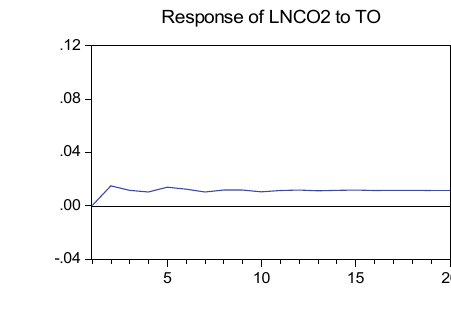
Fig. 2. A response of CO 2 emission to LnGDP, LnEC, FDI,